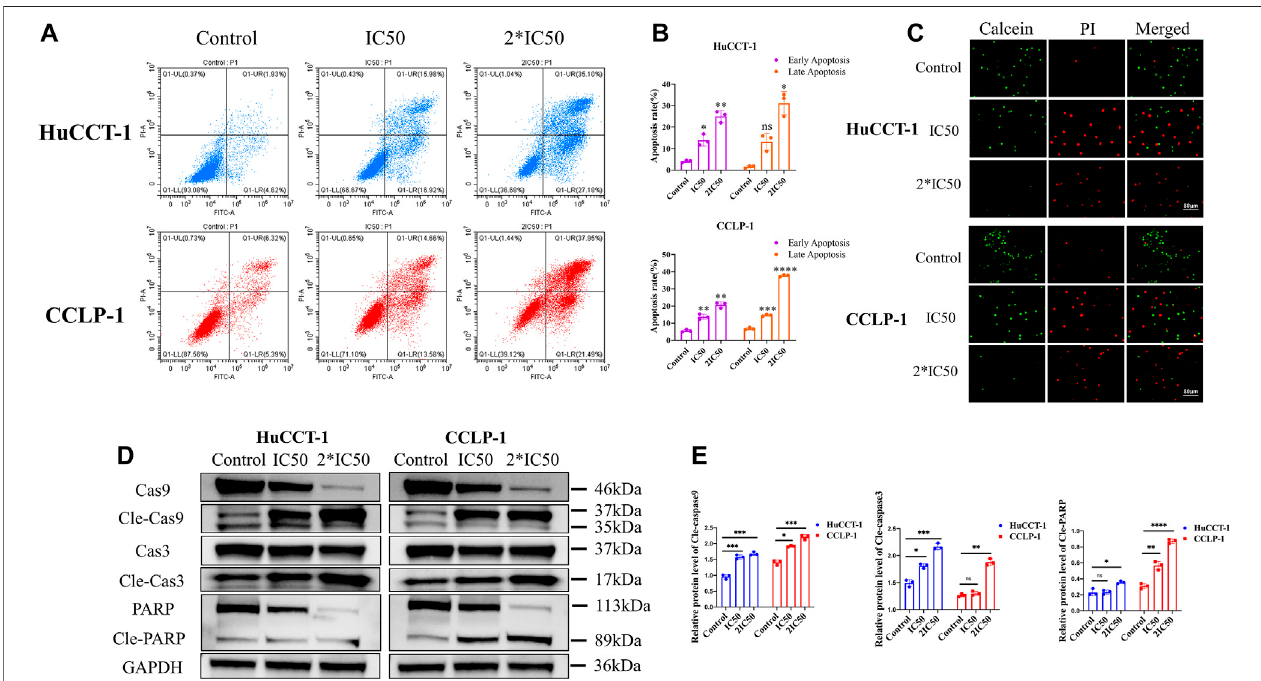
FIGURE 2 | Silibinin induced apoptosis in HuCCT-1 and CCLP-1 cells. (A,B) . Detection of apoptosis by FCM and quantitative analysis of the apoptosis rate. HuCCT-1and CCLP-1 cells were treated with IC50 and 2*IC50 concentrationsofsilibininfor 48 h (C) . The live/dead staining assay results ofthe HuCCT-1 and CCLP-1 cell lines treated withsilibinin for48 h. Red dotsrepresentdead cells and green dotsrepresentsurviving cells. (D) .Westernblottingresults ofHuCCT-1 and CCLP-1cell linestreatedwithIC50 and 2*IC50concentrationsofsilibininfor 48 h. Theapoptosis-related proteins wereidenti fi ed. (E) .The quanti fi cation results